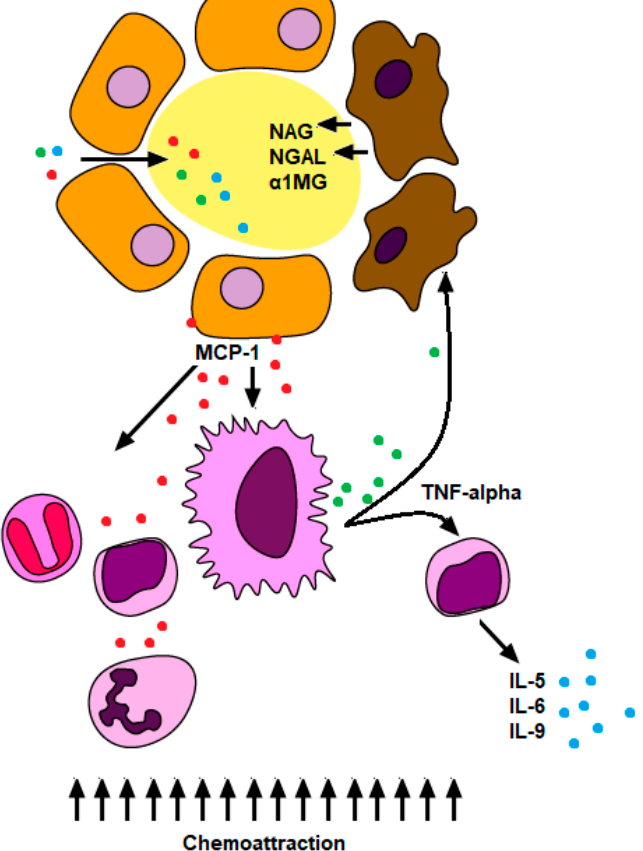
Figure 1. Cytokines and chemokines suggested as biomarkers in acute tubulointerstitial nephritis.